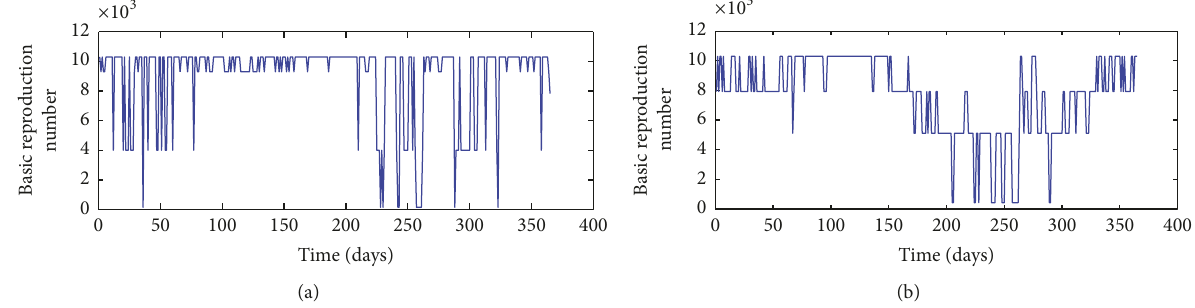
Figure 14: Distribution of 𝑅 0 based on fluctuation of temperature (a) and relative humidity (b) data in